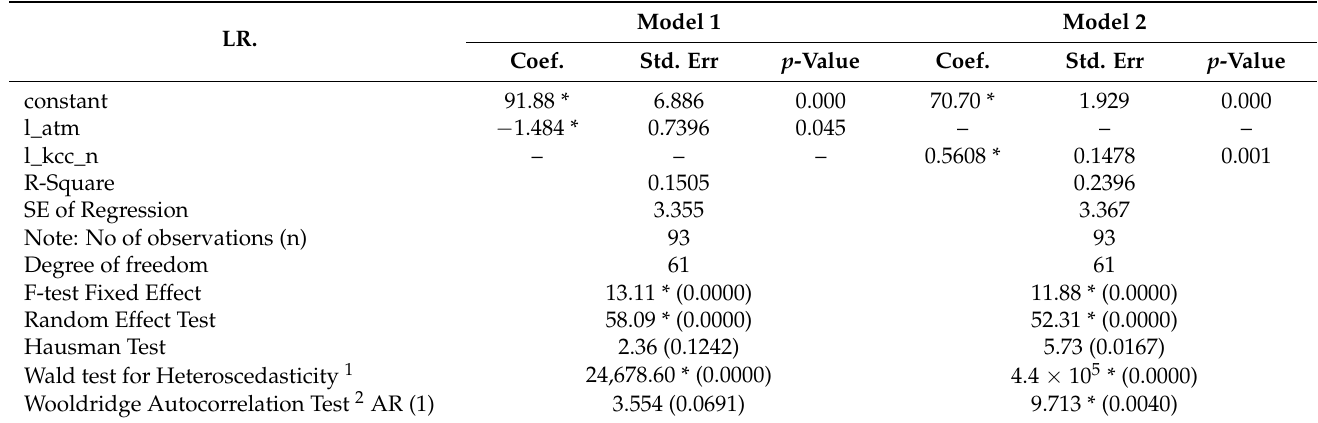
Table 4. Result of Regression Analysis (Static Panel Data